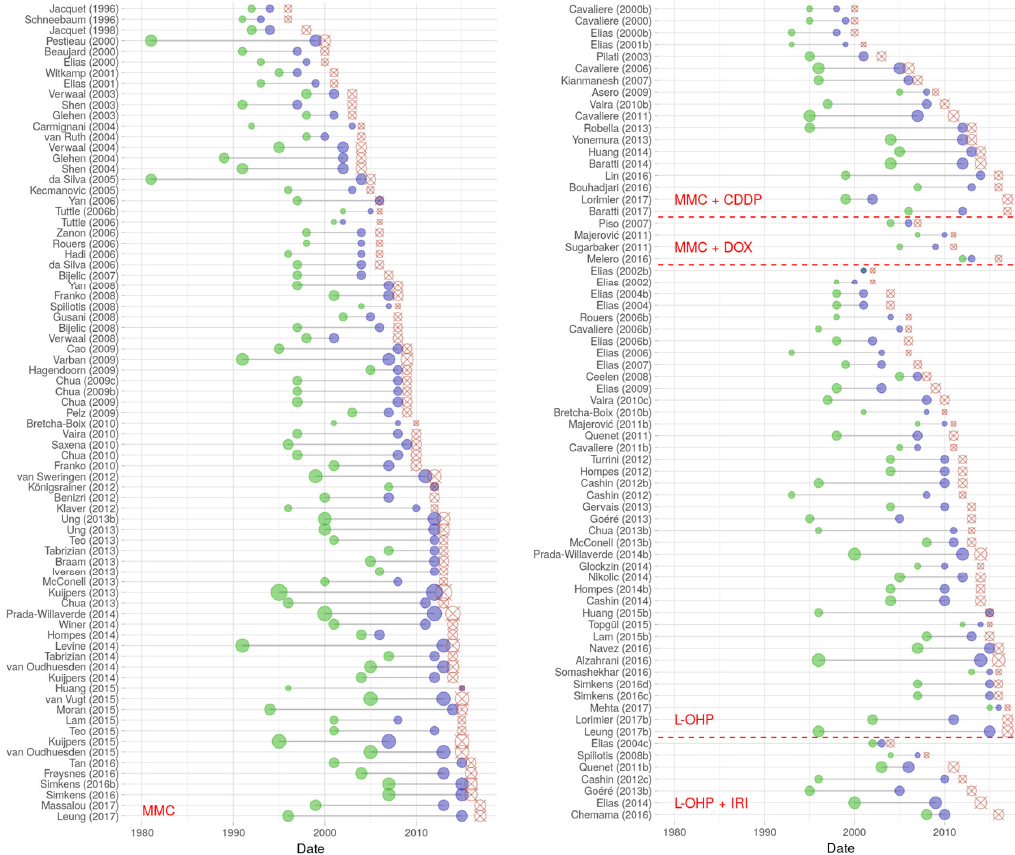
Figure 3. Trial conduct: The Lollipop plot depicts HIPEC clinical trials performed between 1981 and 2016 and published from 1994 to 2017 with different cytostatic drugs (only reports with n > 4 patients and protocols containing MMC or L-OHP single drug or combinations were included). Green dots signify year of trial initiation, blue dots end of recruitment, red crossed markers point to publication dates. Symbols are lg scaled according to number of patients included in the respective study.